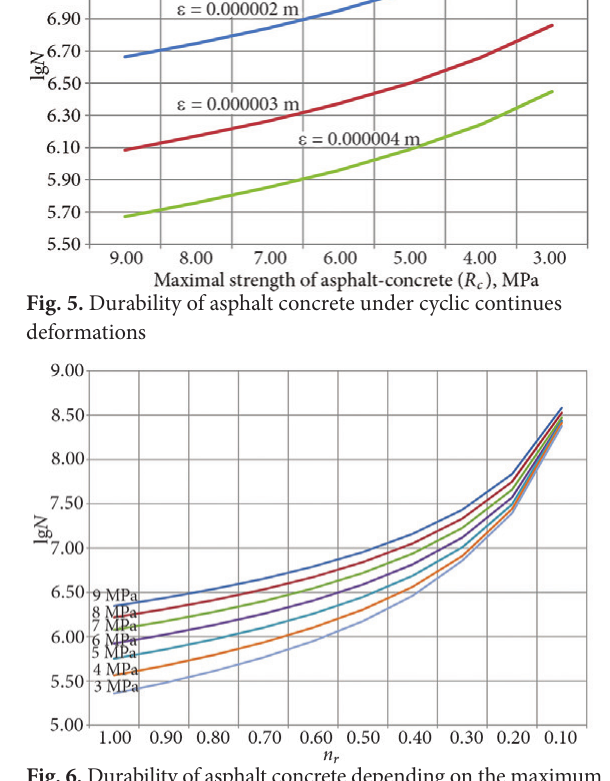
Fig. 6. Durability of asphalt concrete depending on the maximum strength and the amount elastic bounds, involved in the deforma- tion